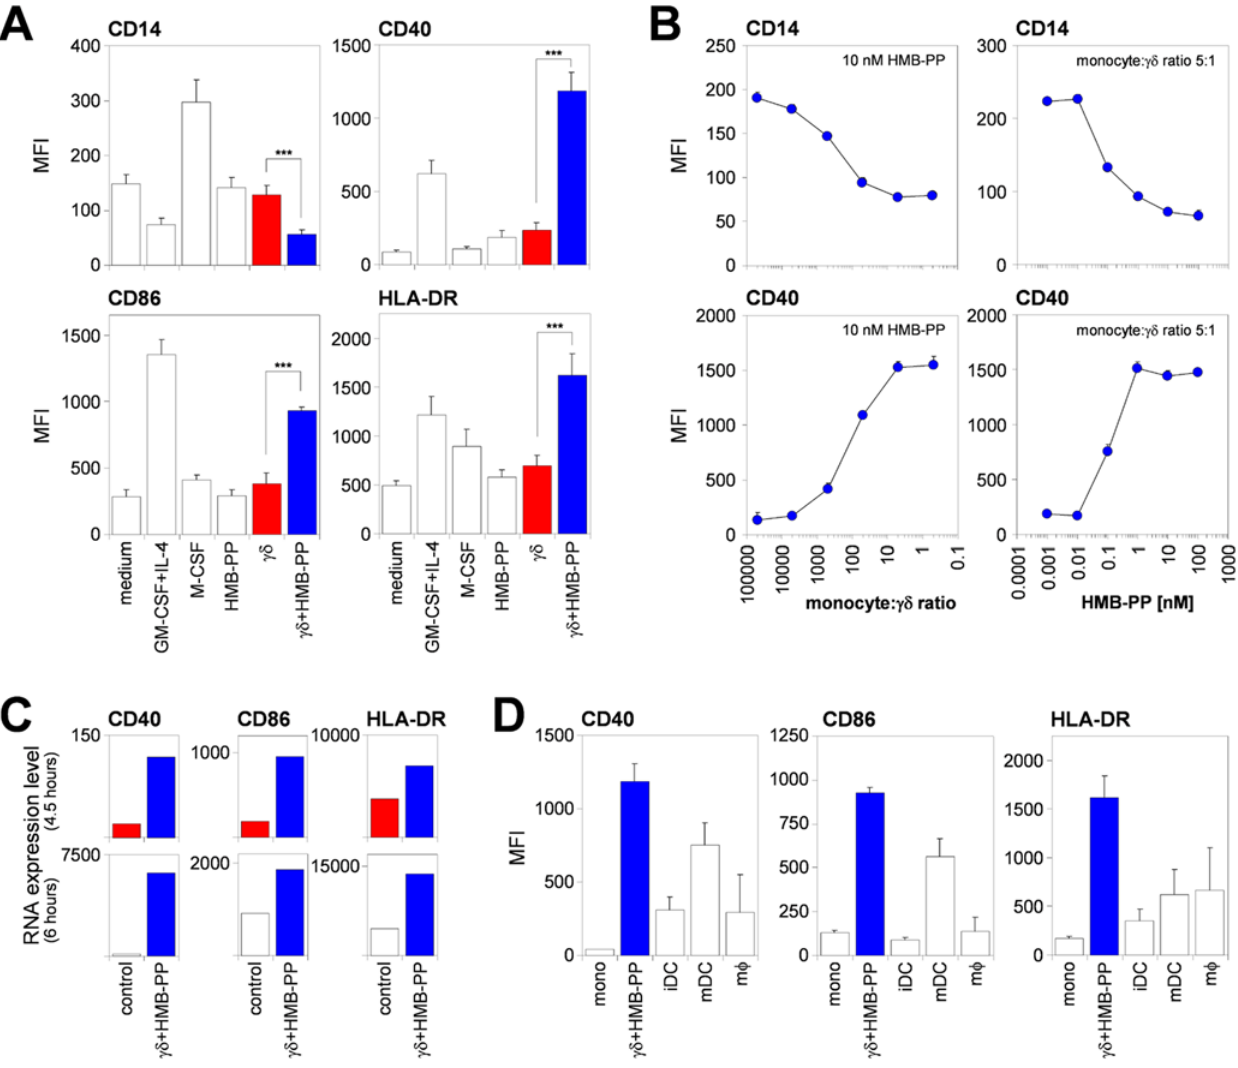
Figure 2. V c 9/V d 2 T cell-activated monocytes acquire APC markers. ( A ) Mean fluorescence intensity (MFI) 6 SEM of CD14, CD40, CD86, and HLA-DR for monocytes after 18 hours of culture under the conditions indicated ( n $ 4). ( B ) MFI 6 SD of CD14 (top) and CD40 (bottom) for monocytes co-cultured with cd T cells at various ratios in the presence of 10 nM HMB-PP (left panels), or with cd T cells at a ratio of 5:1 in the presence of different concentrations of HMB-PP (right panels), as analyzed after 18 hours in triplicate. ( C ) Mean mRNA expression levels of CD40, CD86, and HLA- DR a from duplicate measurements for activated monocytes and cd T cells sorted after 4.5–6 hours from co-cultures in the presence of HMB-PP, compared with control cells sorted from co-cultures in the absence of HMB-PP (top panels), or with freshly isolated, resting monocytes and cd T cells (bottom panels). ( D ) MFI 6 SEM of CD40, CD86, and HLA-DR for freshly isolated monocytes (mono) and monocytes co-cultured with cd T cells and HMB-PP for 18 hours, in comparison with fully differentiated immature DCs (iDC), LPS-matured DCs (mDC), and macrophages (m w ) ( n